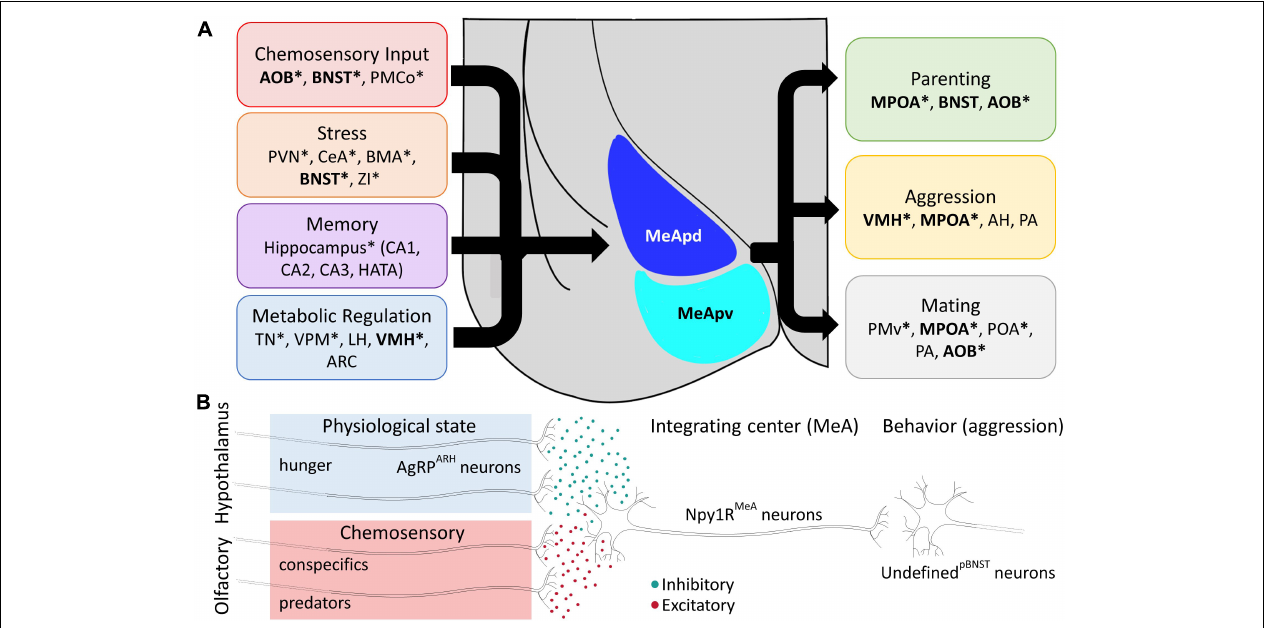
FIGURE 2 | Structural and Functional Integration in Medial Amygdala Circuits. (A) Left: The MeA receives synaptic input from diverse circuits dedicated to stress, chemosensation, memory, and metabolic regulation. Right: Synaptic inputs are integrated in the MeA to direct innate aggressive, parental, and reproductive behaviors. Example connections represent the largest efferent and afferent connections but are not exhaustive. Bolded brain regions indicate regions with identified reciprocal connections (feedback loops) with the MeA. Connections indicated by an asterisk (*) are identified specifically for aromatase-expressing MeA neurons. Posteromedial cortical amygdala (PMCo), paraventricular nucleus of the hypothalamus (PVN), central amygdala (CeA), basomedial amygdala (BMA), zona incerta (ZI), hippocampal-amygdaloid transition area (HATA), ventral posteromedial nucleus (VPM), lateral hypothalamus (LH), arcuate nucleus of the hypothalamus (ARC), anterior hypothalamus (AH), posterior amygdala (PA) and premotor cortex (PMv) (Wu et al., 2009; Dwyer et al., 2022). (B) The MeA receives converging chemosensory and interoceptive input from the AOB and hypothalamus, respectively. During starvation conditions, AgRP neurons release inhibitory signals onto postsynaptic Npy1R neurons in the MeA. Excitatory chemosensory input from the AOB conveys information about predator and/or conspecific cues to the MeA. This dichotomy positions the MeA for scalable outcomes in a hierarchy of survival with respect to social behaviors. When a starving mouse is presented with a conspecific intruder, it prioritizes escape behaviors over territorial aggression, and this behavior is replicated by experimental activation of AgRP fibers in the MeA. AgRP neurons release a multitude of inhibitory signals. Fast acting GABA can act on a short order, while the inhibitory tone from the neuropeptides, NPY and AGRP signals can persist for